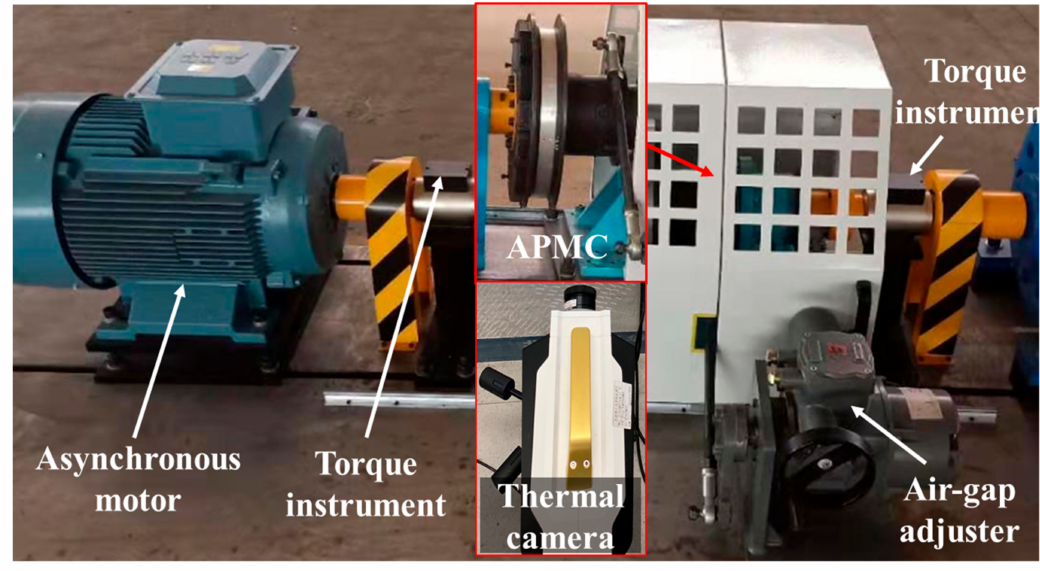
Figure 14. The experiment platform for the studied